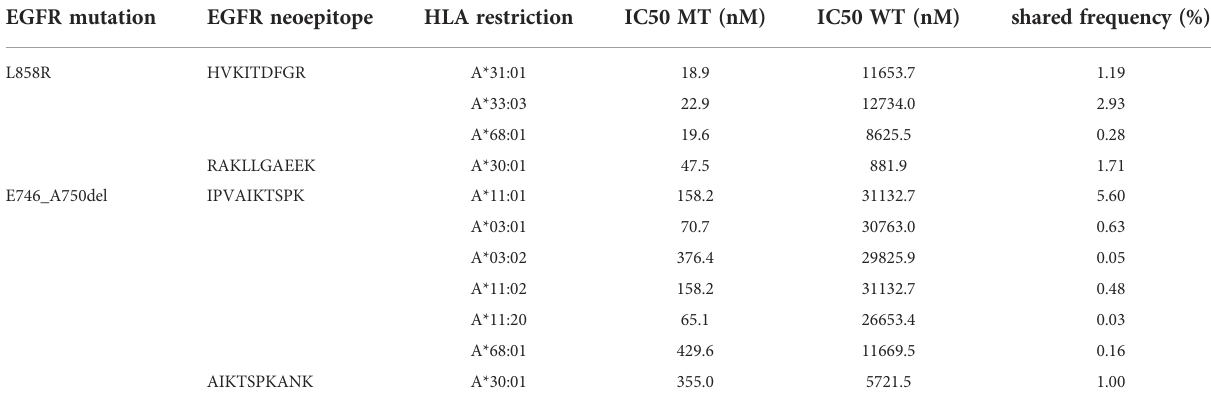
TABLE 1 Shared neoantigens based on EGFR L858R and E746_A750del. EGFR mutation